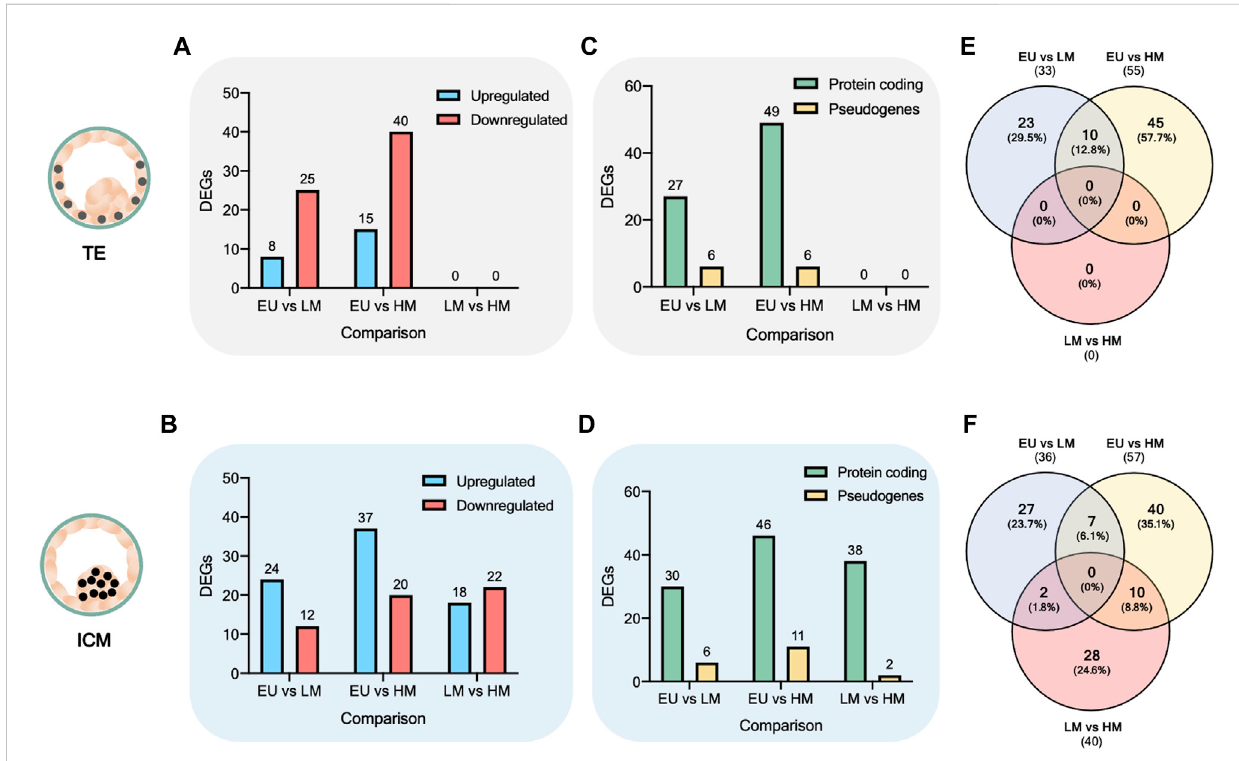
FIGURE 2 Analysis of differentially expressed genes. (A – B) Number of differentially expressed genes (DEGs). DEGs are upregulated (blue) or downregulated (red) in the fi rst comparison factor. (C – D) Biotype of DEGs. (E – F) Venn diagram of overlap between